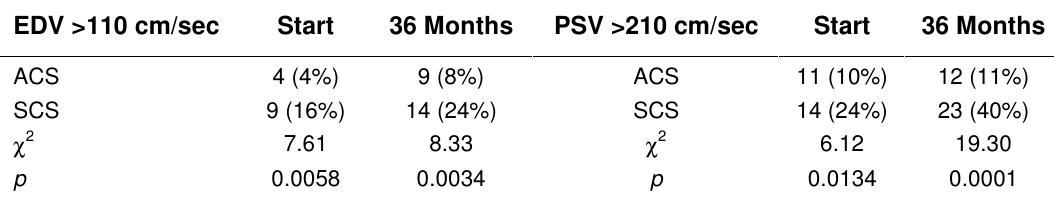
Frequency of Increased Maximal Peak Systolic and End Diastolic Velocities of Examined Carotid Stenoses at the Beginning and End of the Study EDV >110